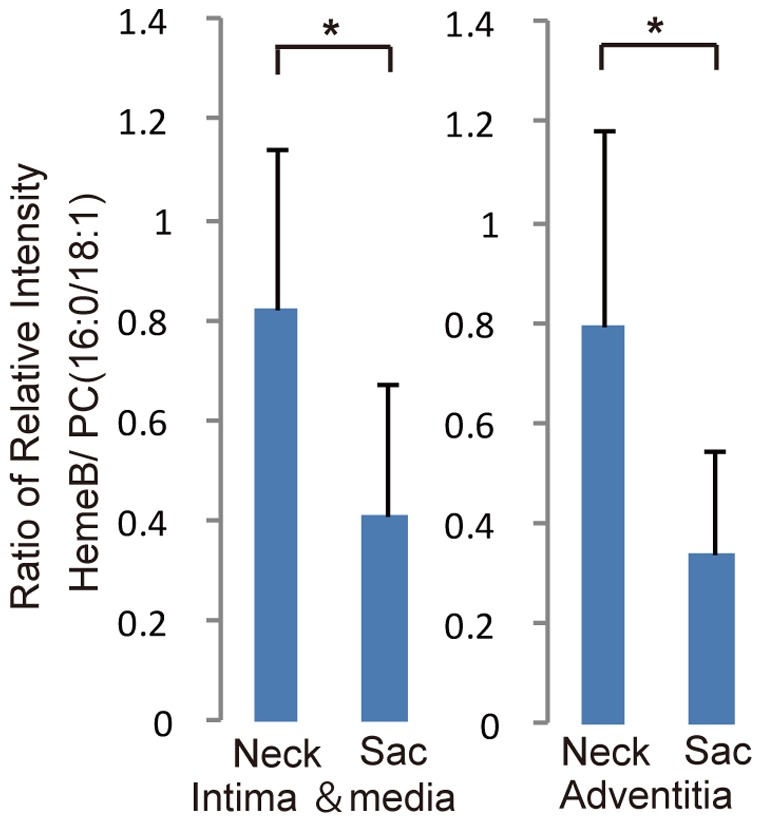
Comparison of HemeB signals.Comparisons of the relative intensity of Heme B/PC(16∶0/18∶1) in both intima–medial and adventitial regions in the AAA sac wall as compared with those in the neck wall. *P<0.001 indicates a statistically significant difference.